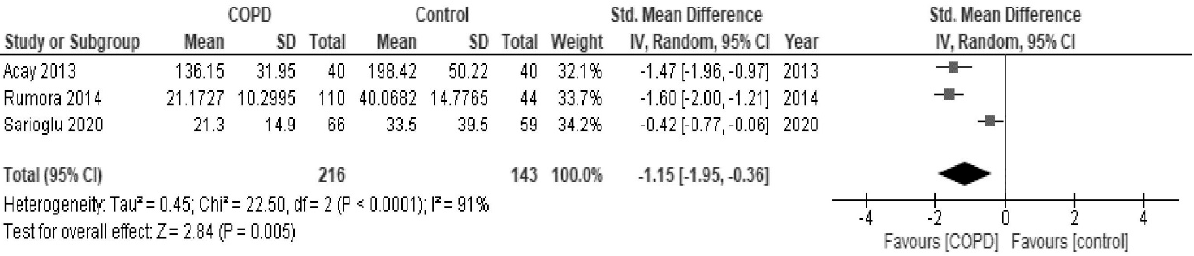
Figure 2. Forest plot of paraoxonase activity in all studies. COPD: chronic obstructive pulmonary disease; Std: standard; SD: standard deviation; CI: confidence interval; IV: interval variable.